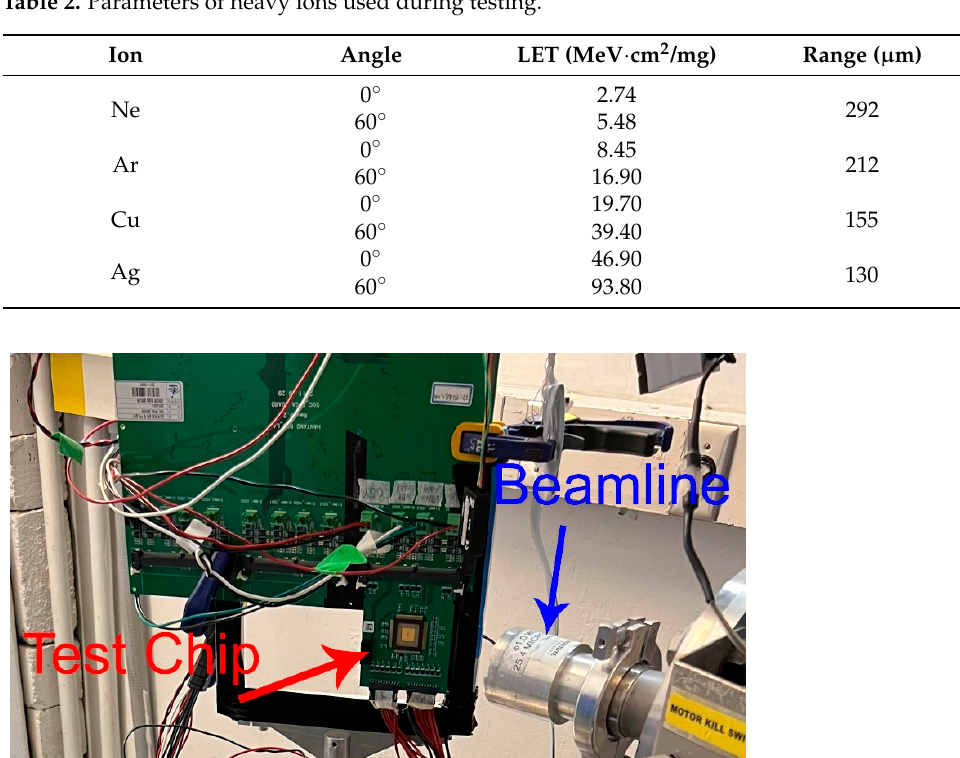
Table 2. Parameters of heavy ions used during testing.